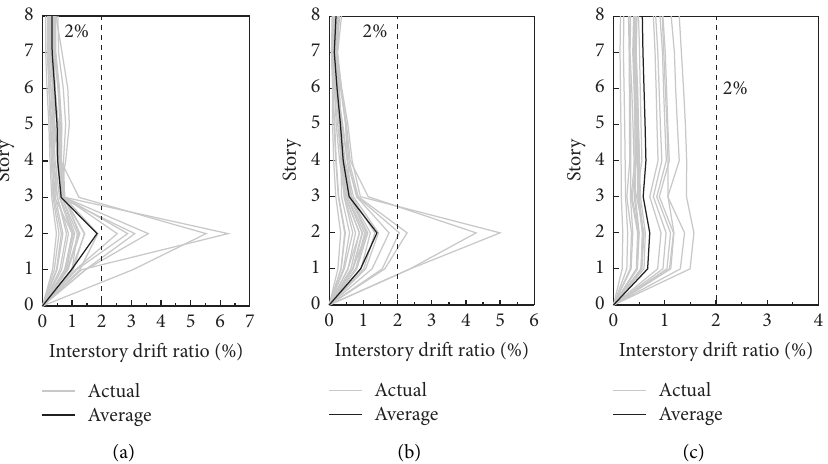
Figure 10: Comparison of the peak interstorey drift distributions under major earthquakes. (a) PRCFCP. (b) PRCFCP -USD. (c) PRCFCP